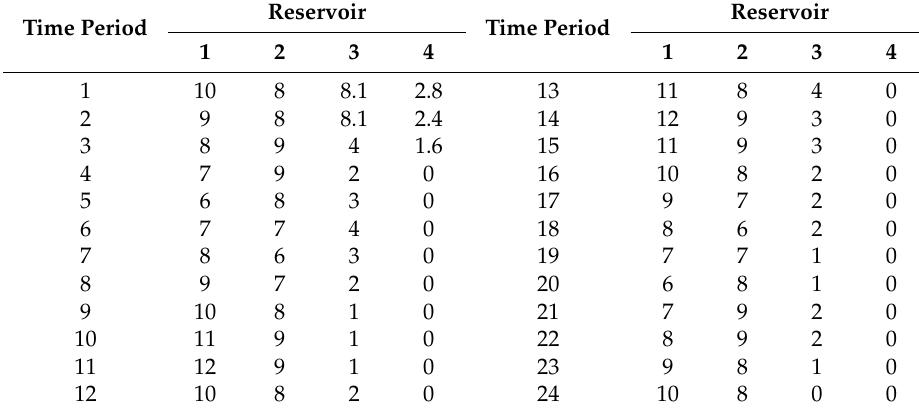
Table A4. Reservoir inflows ( × 10 4 m 3 ).